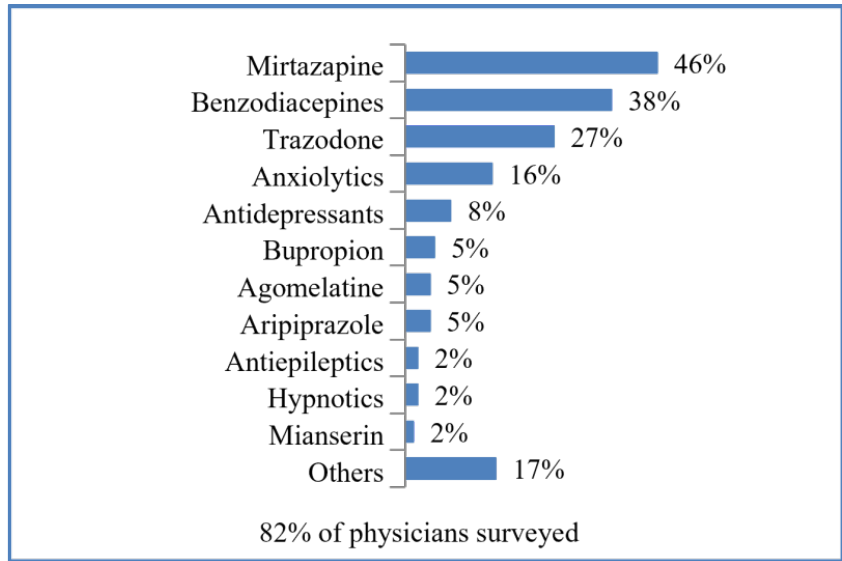
Figure 1. List of psychoactive drugs with which psychiatrists often associate duloxetine. Duloxetine stands out from venlafaxine for its efficacy against pain. However, ven- lafaxine is somewhat more effective against sadness or apathy. See the complete diagram in Figure 2.